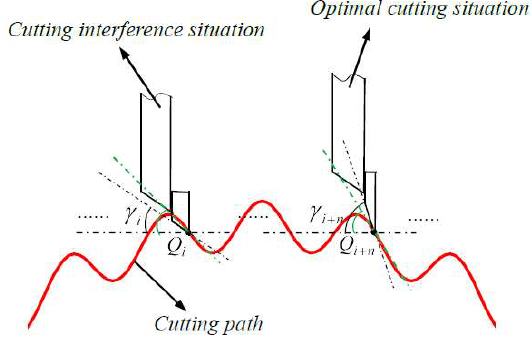
Figure 11. Illustration of geometry between tool nose radius and radial cross-section curve. (a) The surface radial curve for tool nose radius optimum; ( b ) Geometry relation between tool nose radius and surface radial curve curvature radius.